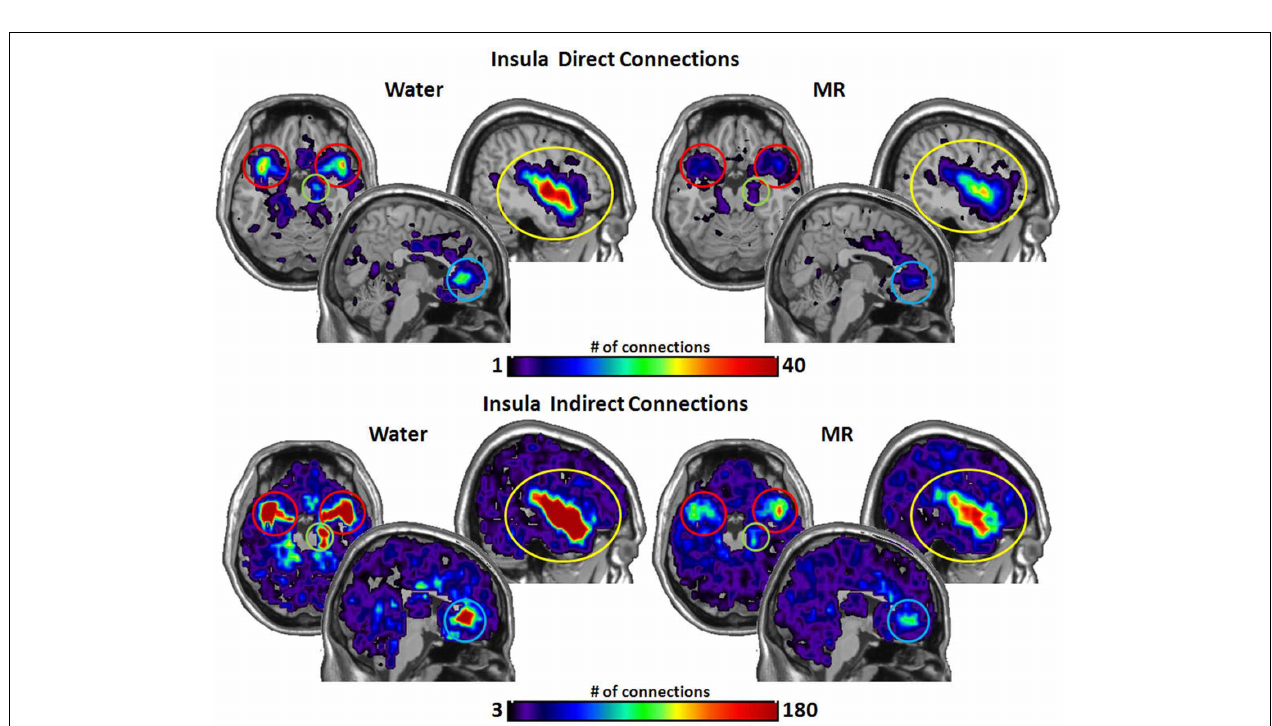
amygdala (red circle) and the right hippocampus (green circle). On the top right are sagittal slices (MNI x = 139) through the insula (yellow circle). Finally the images on the bottom are a sagittal slices (MNI x = 95) through the anterior cingulate (blue circle). Figures 3 – 7 are shown with these same slices. The figure highlights that the superior temporal pole, right hippocampus, the ACC, and the insula have greater connectivity in the water condition than in the MR condition during resting state.